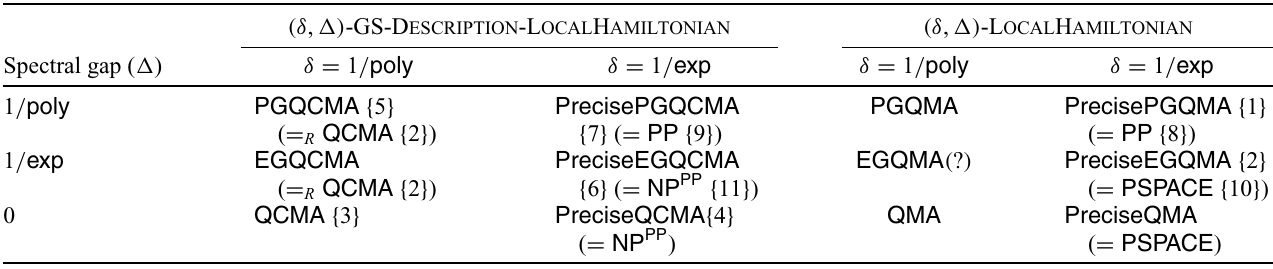
TABLE I. Complexity of variants of the L OCAL H AMILTONIAN problem as a function of the parameters δ , the promise gap, and (cid:5) , the spectral gap. The problem is complete for the class mentioned in each cell. For reference, we mention in curly brackets the theorem number corresponding to the results proved in this work. The question mark corresponding to the entry EGQMA indicates that the result is a conjecture and the notation “ = R ” denotes equivalence under randomized reductions (defined in Sec. V C). (δ , (cid:5)) -GS-D ESCRIPTION -L OCAL H AMILTONIAN (δ , (cid:5)) -L OCAL H